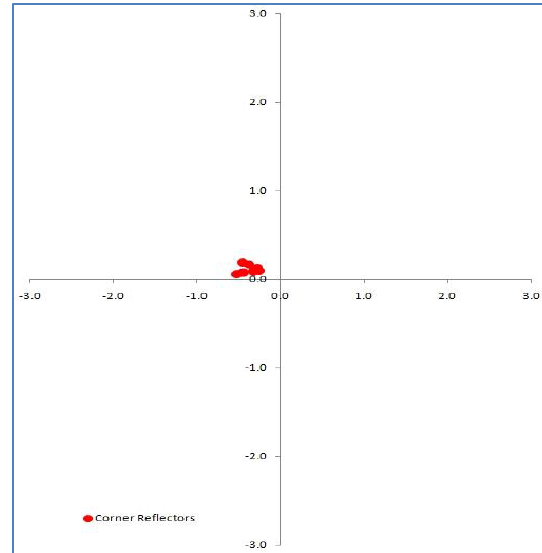
Figure 15. Scatterplot for corner reflectors [Meters]